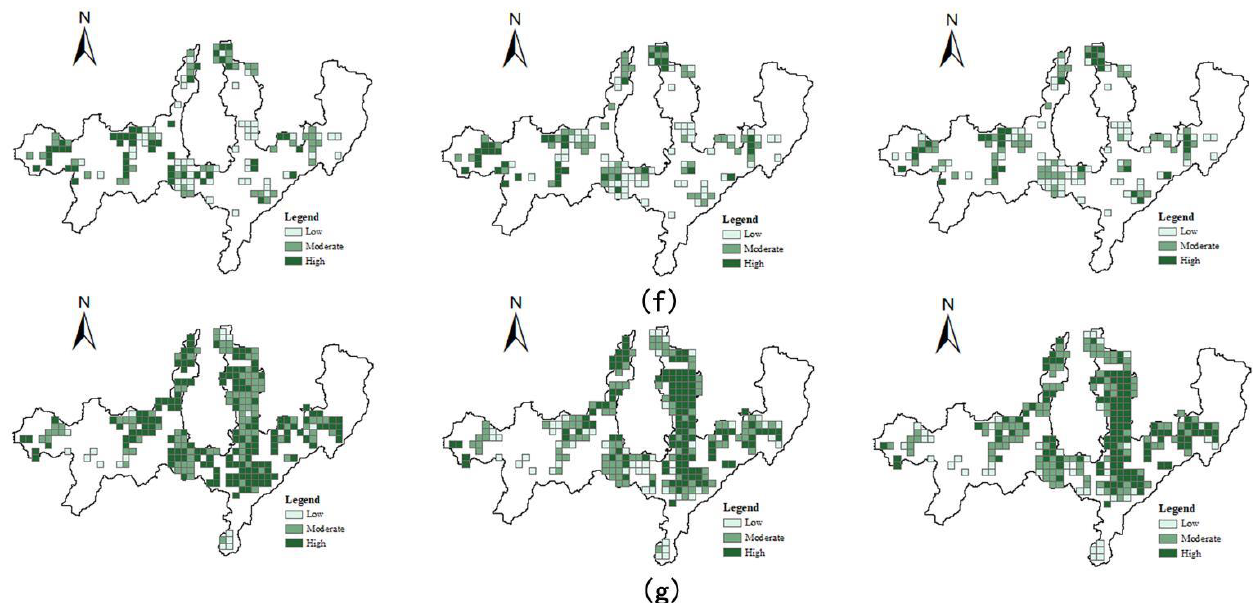
Figure 9. Spatial distribution maps of the coupling coordination of ( a ) Leiothrix lutea bio-reserve, ( b ) Emberiza aureola bio-reserve, ( c ) fir forest, ( d ) other woodlands, ( e ) non-woodlands, ( f ) shrub- lands, and ( g ) mixed evergreen broad-leaved forest with the settlement-pattern indexes AREA_MN, CONTAG, and LSI, respectively (left to right).